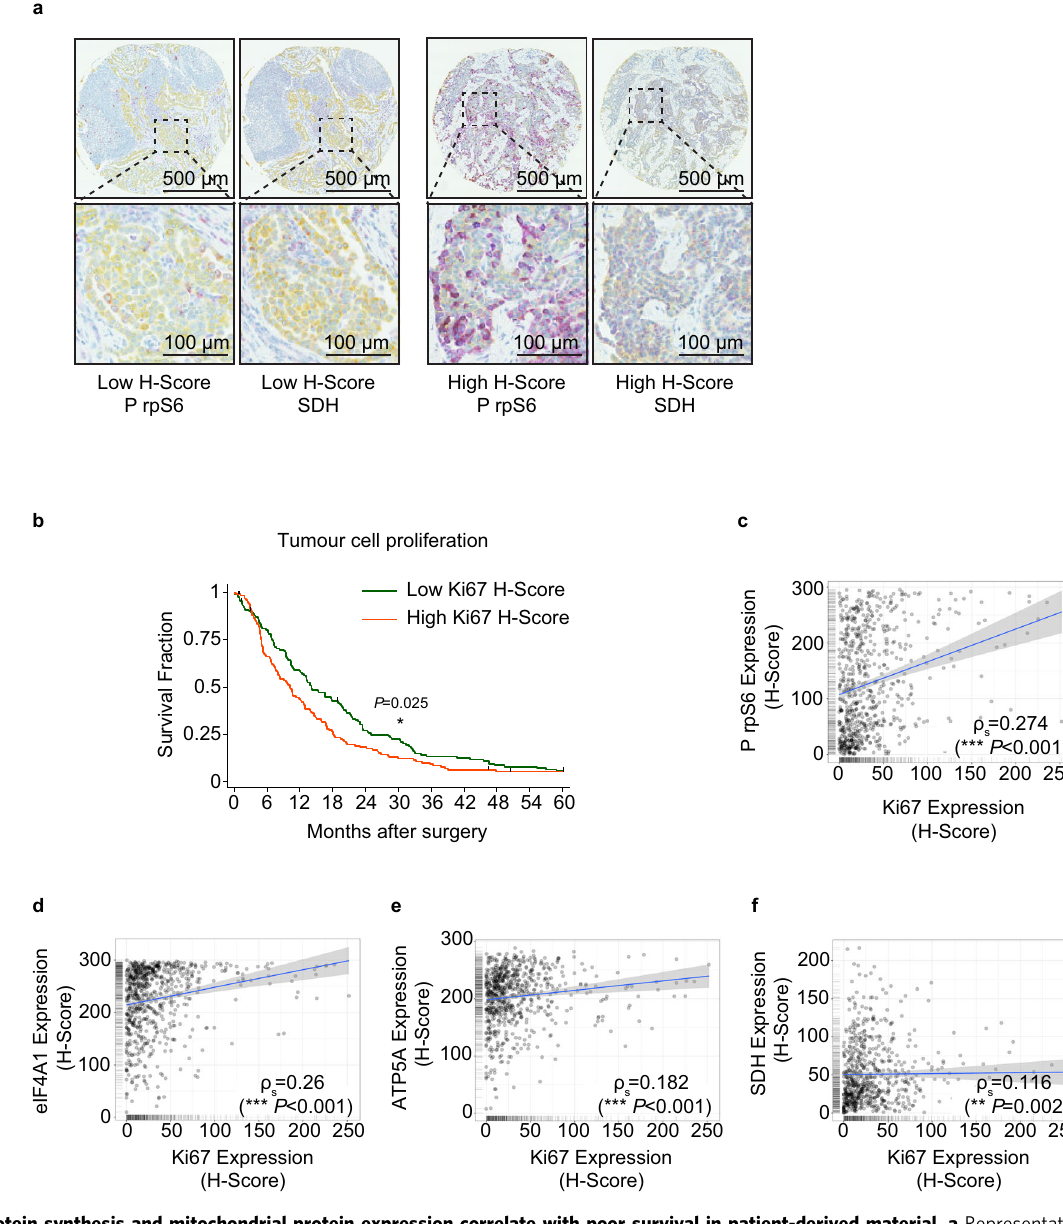
Fig. 2 Protein synthesis and mitochondrial protein expression correlate with poor survival in patient-derived material. a Representative section of tissue microarray (TMA) probed with antibodies against phospho-Ser240/244 rpS6 (magenta) and SDH (magenta). Tumour areas within the TMA cores were identi fi ed by cytokeratin staining (yellow). Visiopharm ® software was used to quantify the magenta staining in the tumour area. b Kaplan – Meier plot, showing Ki67 staining is a strong predictor of survival. The 272 patients included in the TMAs, were split into two equally sized groups according to Ki67 H-score. A log-rank test was performed to determine the signi fi cance of differences in survival (* p = 0.025). c Scatter plot of the H-scores of rpS6 phosphorylation (mTOR activity) and Ki67 expression in mesothelioma TMAs. Linear regression analysis was performed by Spearman ’ s rank correlation, the coef fi cient was 0.274. The linear regression fi t is depicted with a blue line. The grey band shown is the 95% con fi dence interval. d Scatter plot of the H-scores of eIF4A1 expression and Ki67 expression in mesothelioma TMAs. Linear regression analysis was performed by Spearman ’ s rank correlation, the coef fi cient was 0.26. The linear regression fi t is depicted with a blue line. The grey band shown is the 95% con fi dence interval. e Scatter plot of the H-scores of mitochondrial ATP5A expression and Ki67 expression in mesothelioma TMAs. Linear regression analysis was performed by Spearman ’ s rank correlation, the coef fi cient was 0.182. The linear regression fi t is depicted with a blue line. The grey band shown is the 95% con fi dence interval. f Scatter plot of the H-scores of mitochondrial SDH expression and Ki67 expression in mesothelioma TMAs. Linear regression analysis was performed by Spearman ’ s rank correlation, the coef fi cient was 0.116. The linear regression fi t is depicted with a blue line. The grey band shown is the 95% con fi dence